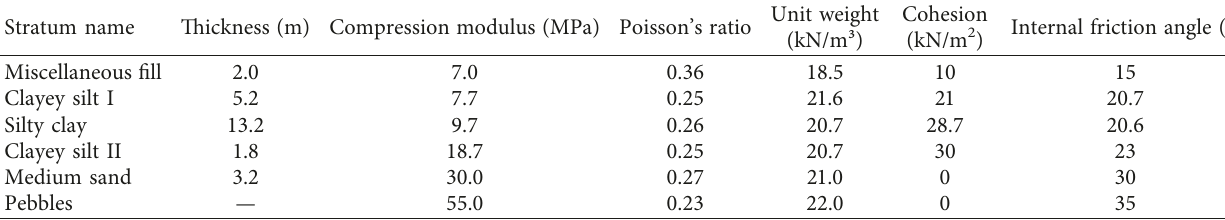
Table 1: Physical and mechanical parameters of the soil.